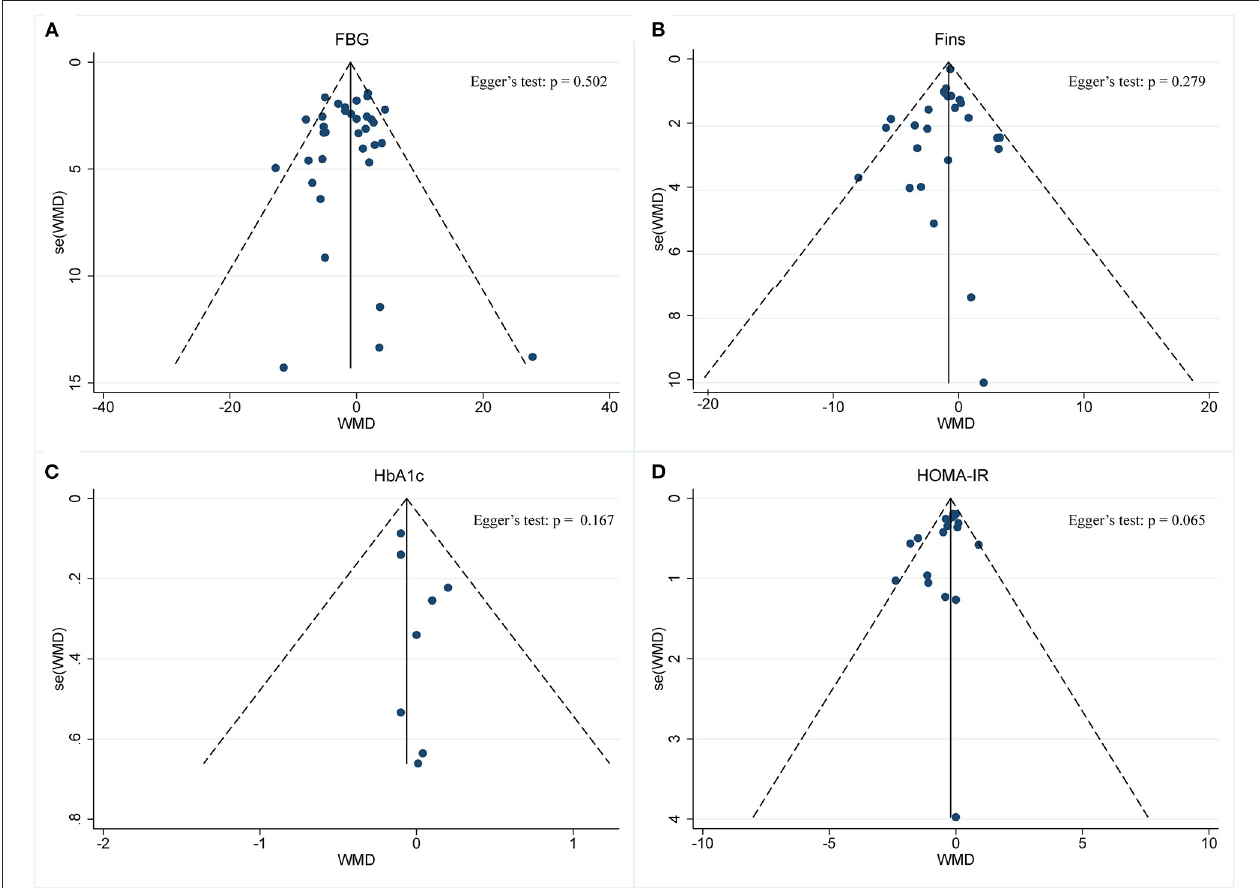
FIGURE 6 | Funnel plot displaying no publication bias in the studies reporting the impact of intermittent fasting on glycemic control (A) FBG, (B) Fins, (C) HbA1c, (D)